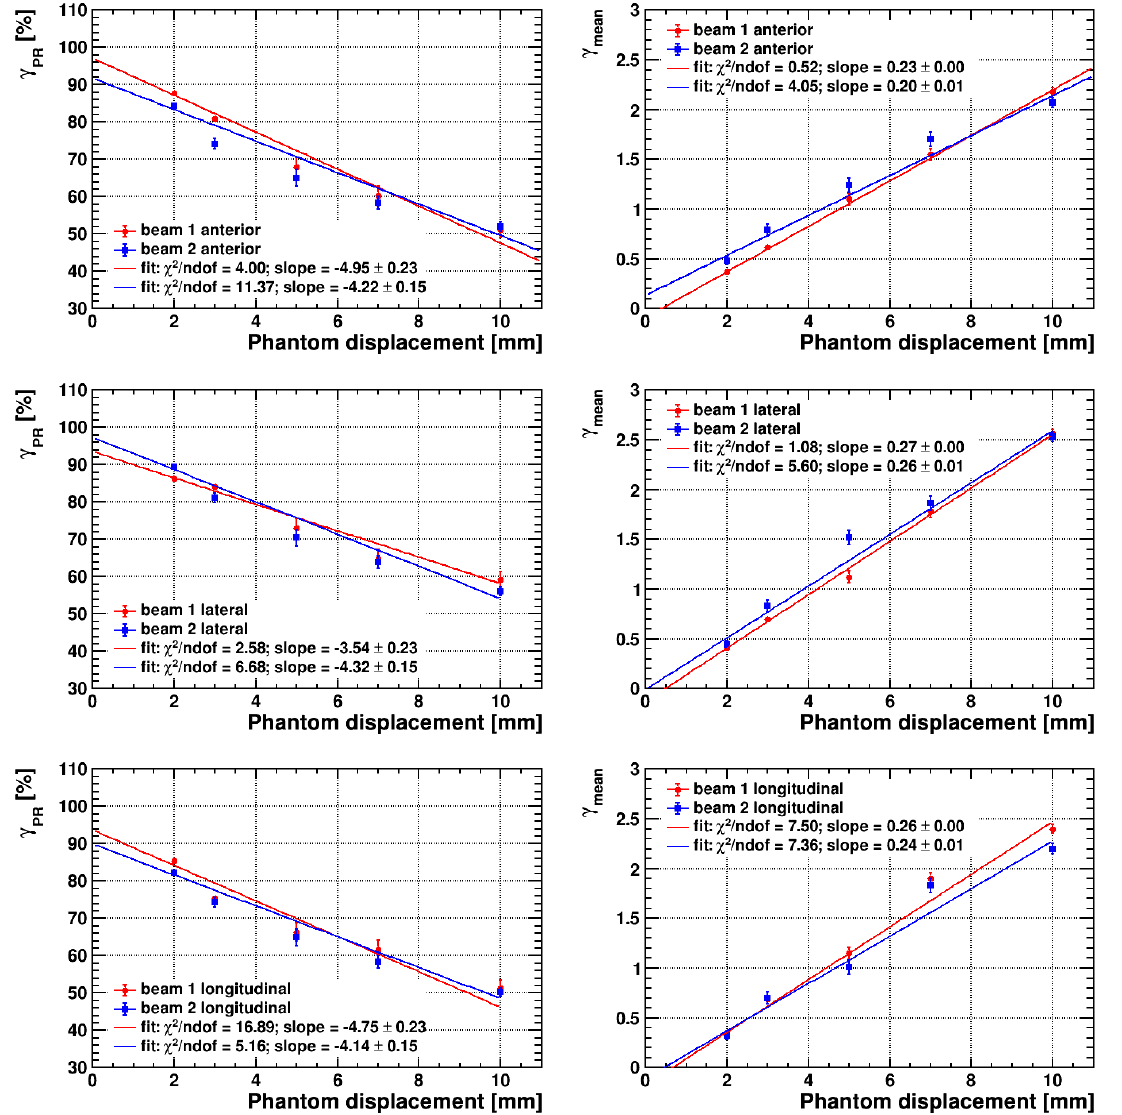
Figure 6. Measured γ PR and γ mean indexes as functions of phantom anterior ( top ); lateral ( middle ) and longitudinal ( bottom ) displacements for both beam 1 and beam 2 used in the simulated treatment